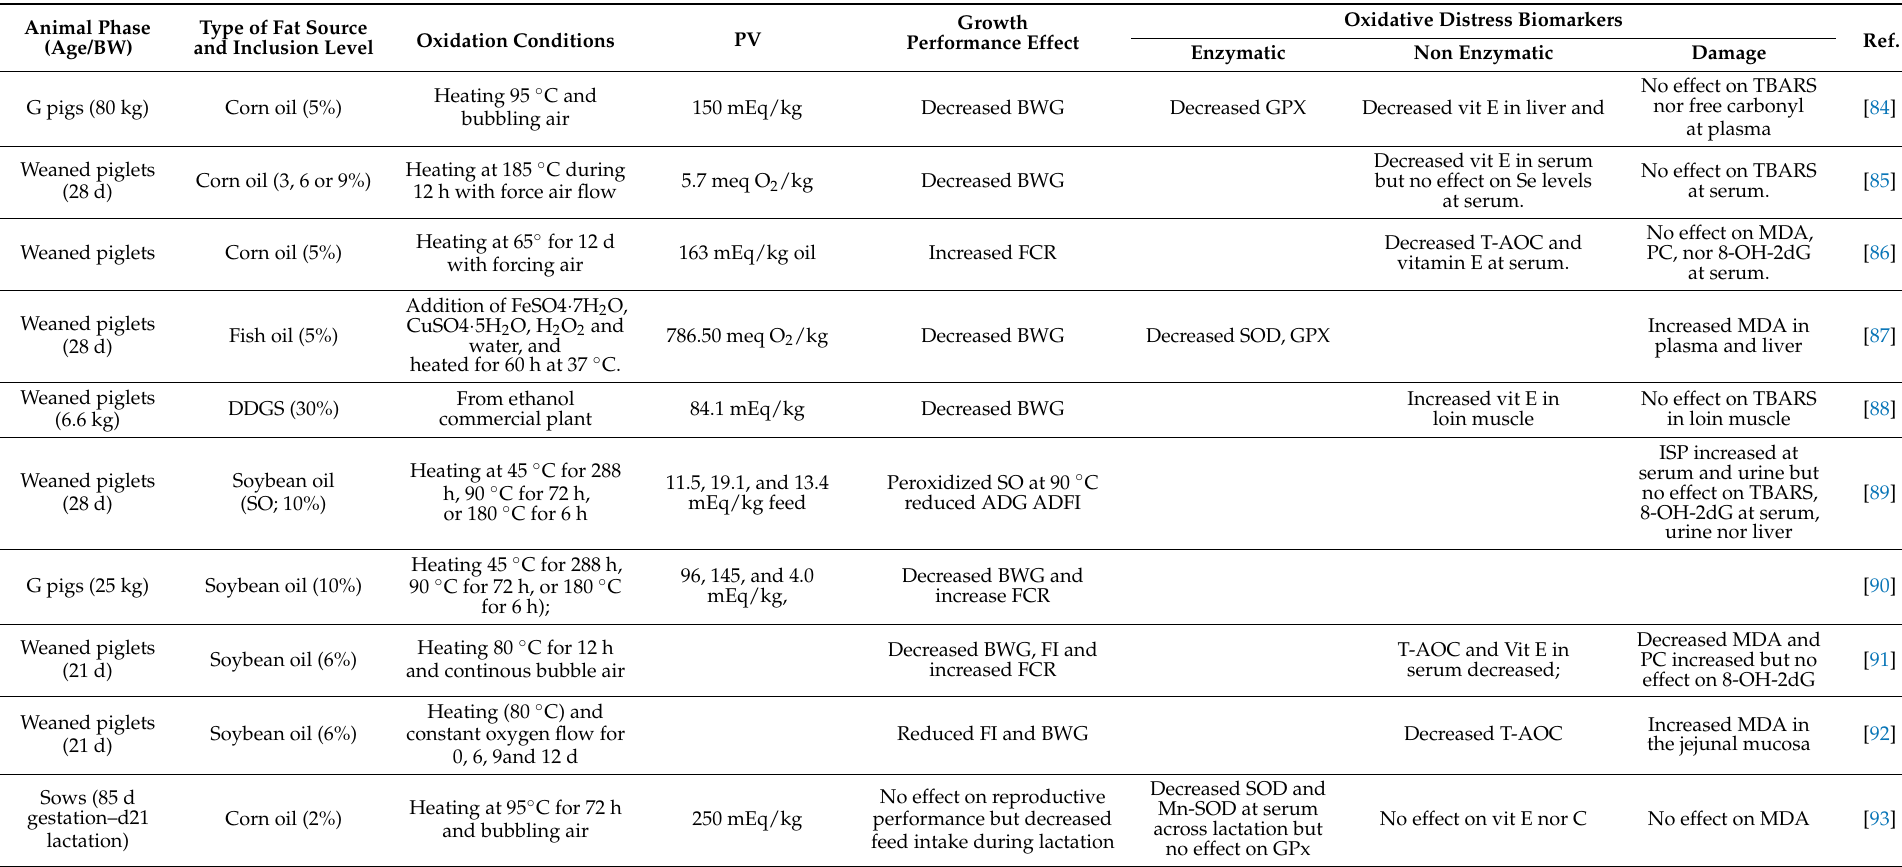
Table 2. Summary of the dietary oxidative challenges models based on oxidized fat discussed within this review in swine, including type of fat, oxidation conditions, resultant fat characterization and inclusion level in feed, and results, including growth performance impact, oxidative stress markers evaluated classified by enzymatic, non-enzymatic or oxidative